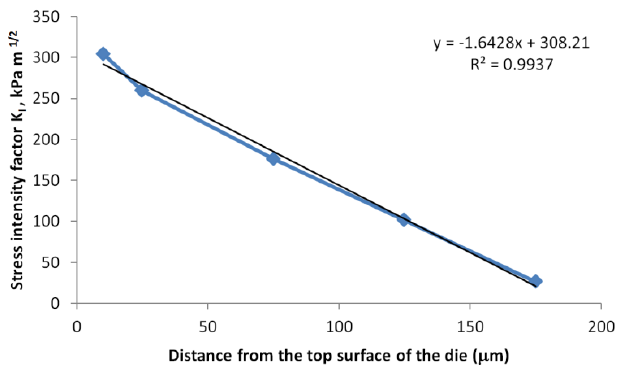
Figure 14. Effect of crack location on stress intensity factor.